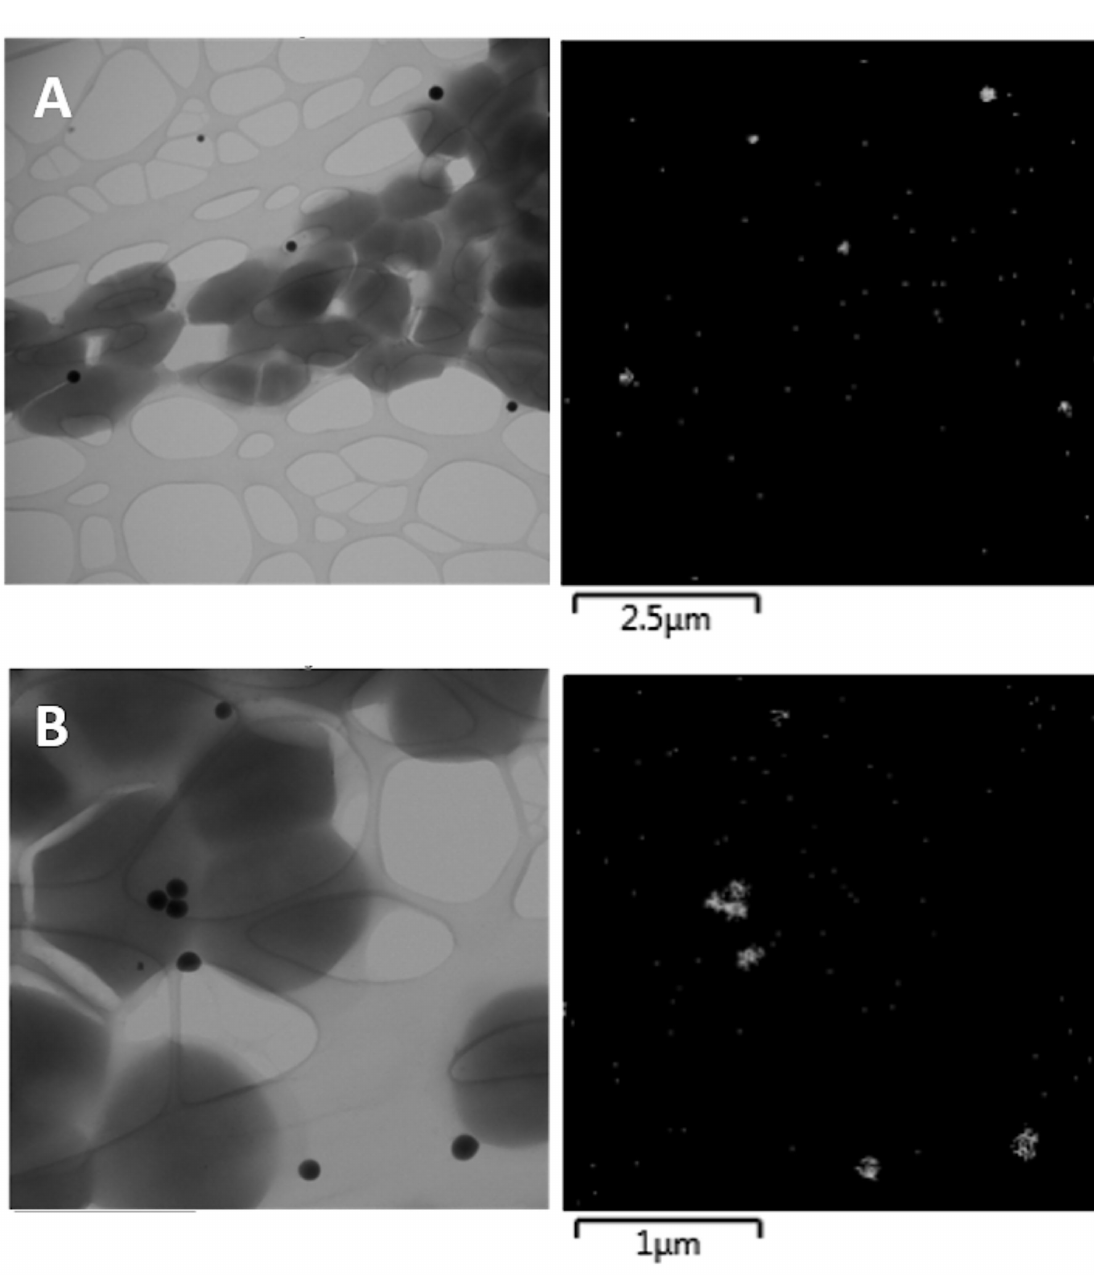
Figure 2. Bright field TEM images ( left ) of the CCDM 144 ( A ) and CCDM 922A ( B ) selenized strains with the corresponding energy-dispersive X-ray (EDX) maps of the signal intensity of selenium Se K α 1 spectral line ( right